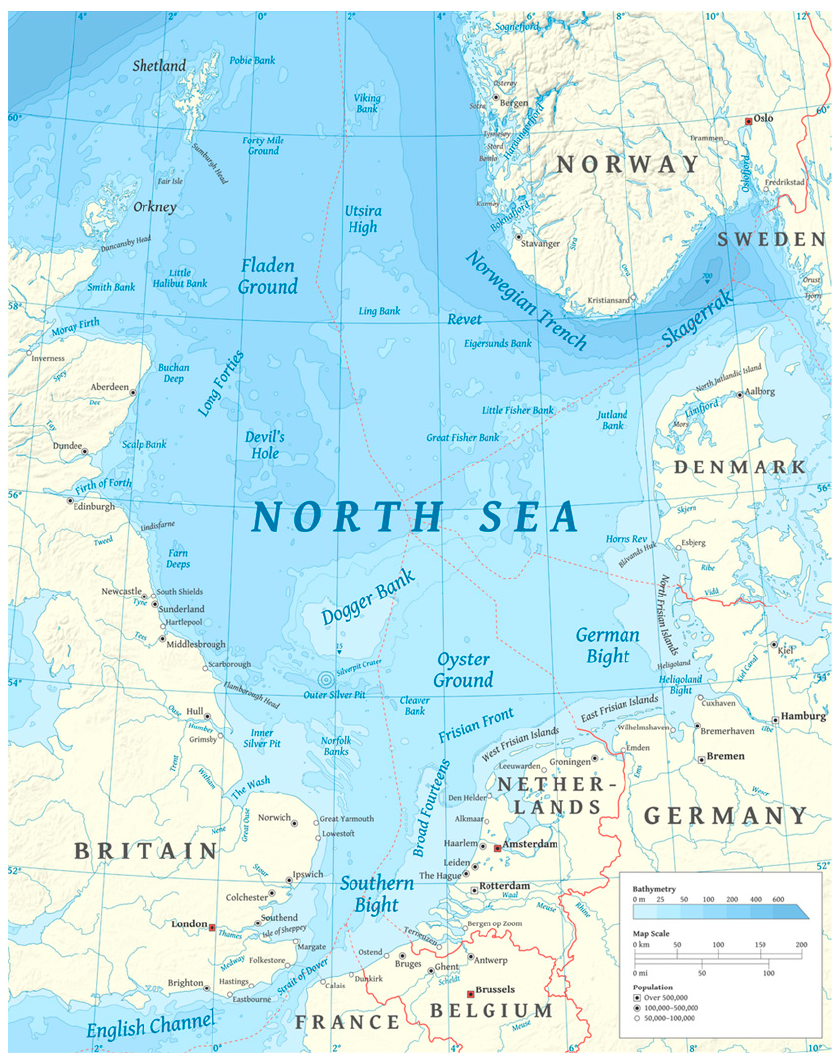
Figure 1. The North Sea and its adjacent countries. Adapted from Wikimedia Commons [3].